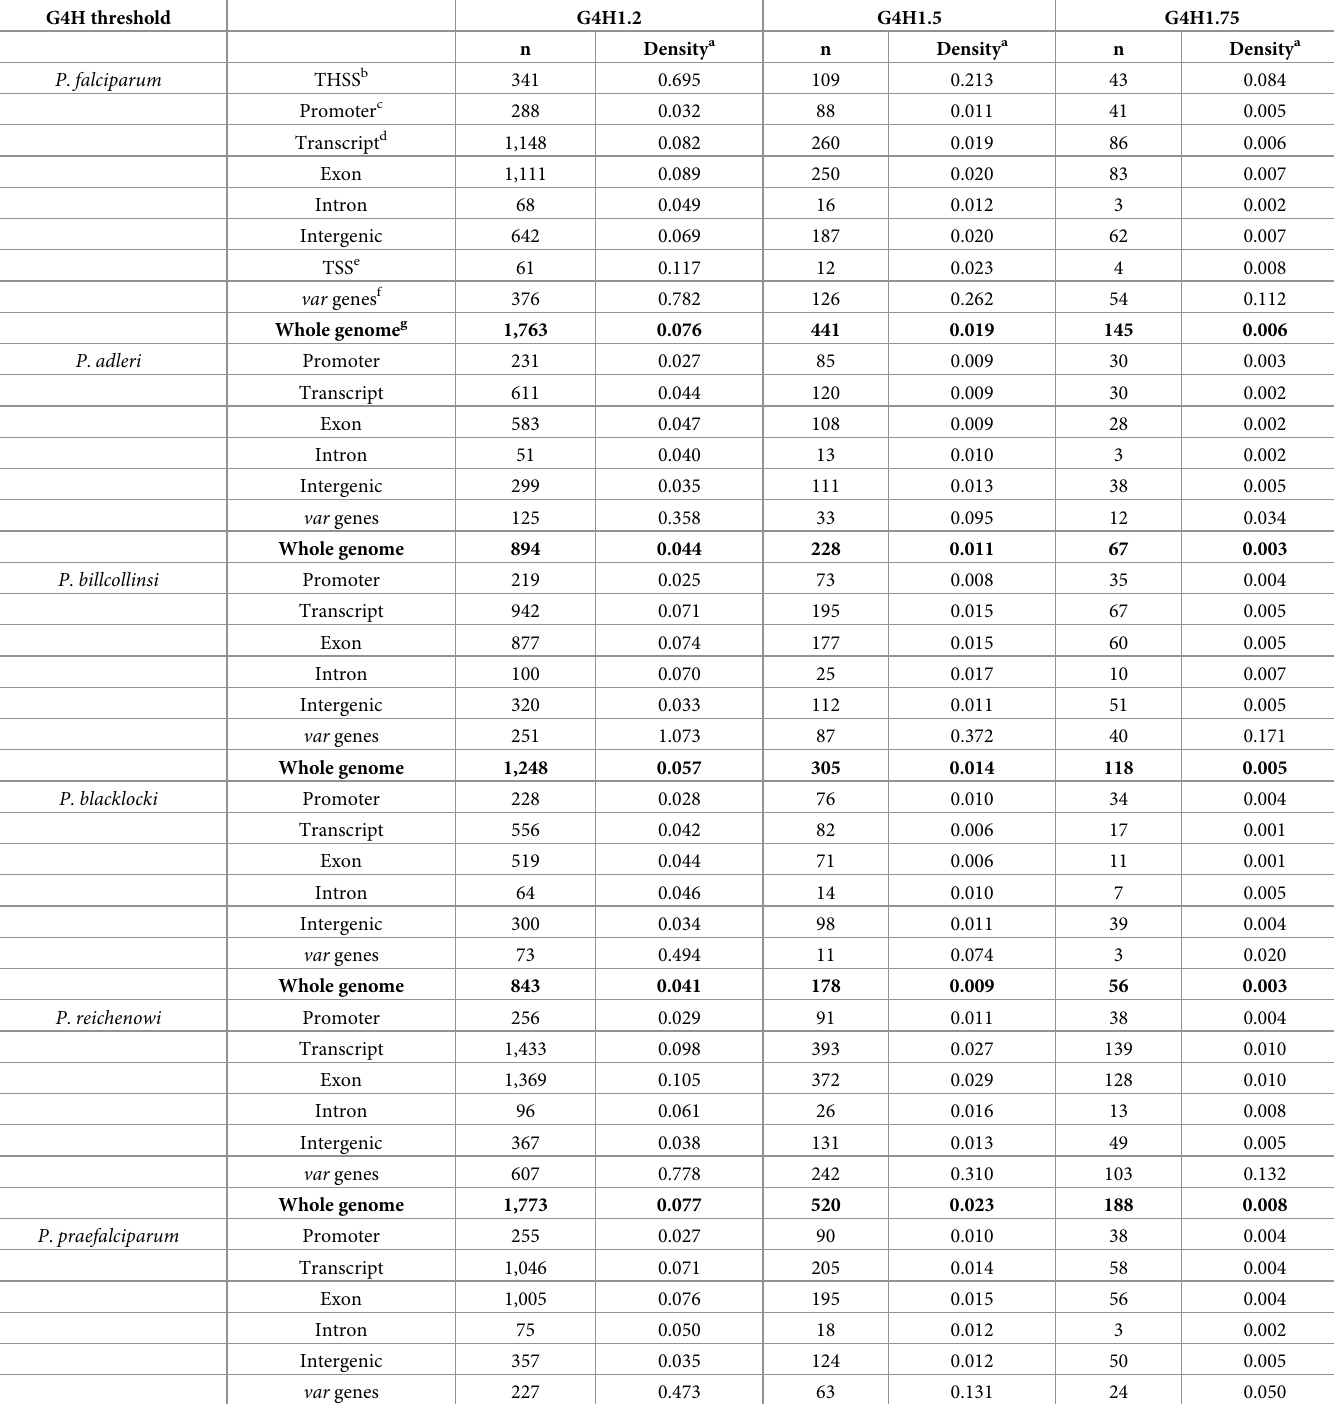
Table 1. Number and density of G4FS that are present in different genome features in P . falciparum and in related species of Plasmodium predicted with G4Hunter. For each region, the total number of G4 motifs overlapping to the region intervals was calculated. G4H